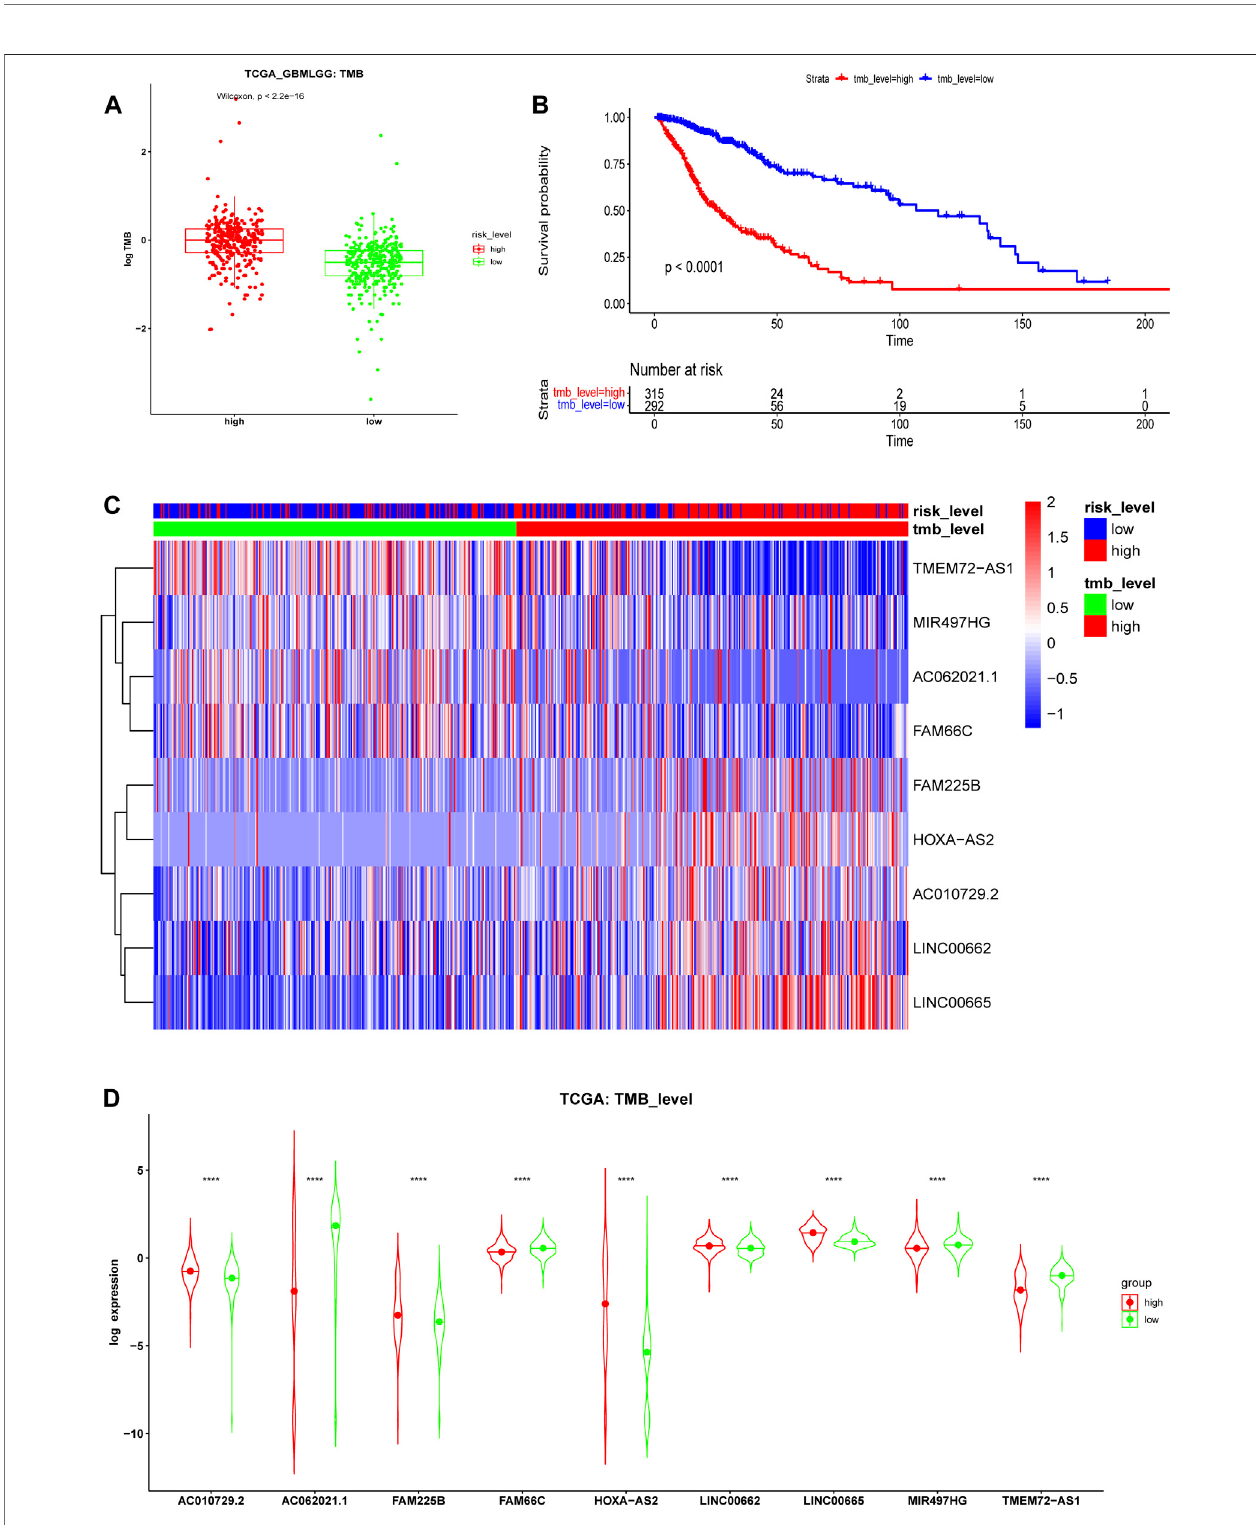
FIGURE11| Tumormutationalburden(TMB)analysisintheTCGAcohort. (A) TMBlevelsofhigh-andlow-riskgroups. (B) Kaplan-Meiersurvivalanalysisbetween high- and low-TMB groups divided by the median TMB. (C) Expression heatmap and (D) violin plots of 9 ferroptosis-related lncRNAs between the high- and low-level TMB groups in the TCGA